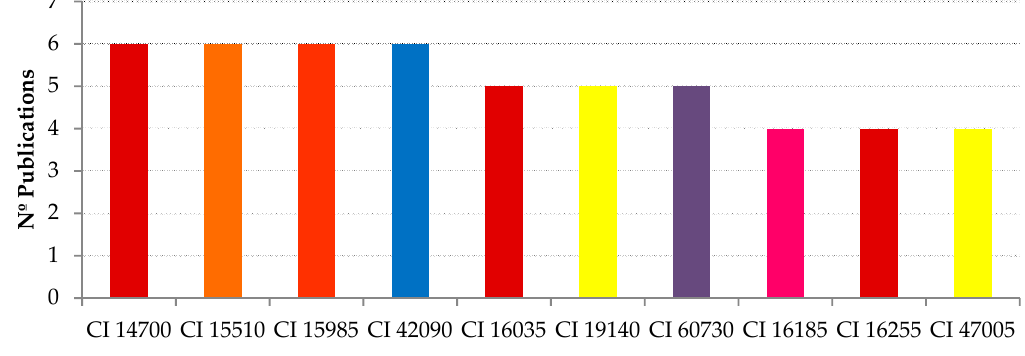
Figure 1. Top 10 permitted dyes analysed in cosmetics in the last 10 years (bar colour corresponds with the shade of each dye).